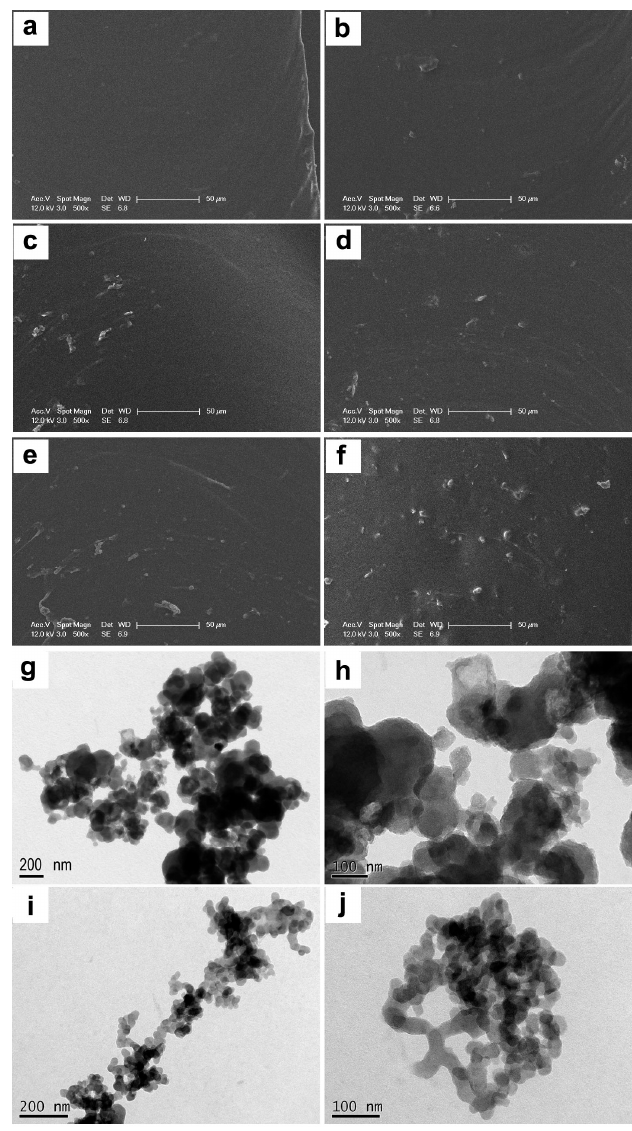
Figure 5. SEM and TEM images of the cross-sections of WPU and WPU-SF films: ( a – f ) SEM images of the WPU17, WPU17-SF1, WPU17-SF2, WPU17-SF3, WPU17-SF4, and WPU17-SF5 films in the WPU17, WPU17-SF1, WPU17-SF2, WPU17-SF3, WPU17-SF4, and WPU17-SF5 films in sequence; ( g – j ) TEM images of the WPU17-SF3 film.